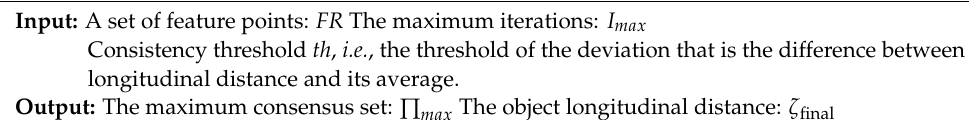
Algorithm 1. Implementation flow for RANSAC filtering (example of longitudinal